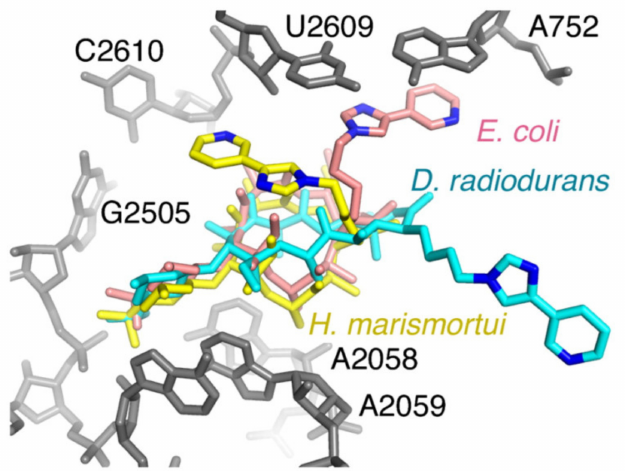
Figure 4. Telithromycin bound to the E. coli ribosome. A comparison of the conformations reported for telithromcyin bound to the ribosome. 23S rRNA for E. coli is shown in gray. Telithromycin models from H. marismortui (gold), D. radiodurans (cyan), and E. coli (pink) are shown. Nitrogens in the alkyl–aryl arm are also shown for reference; reproduced with permission by PNAS